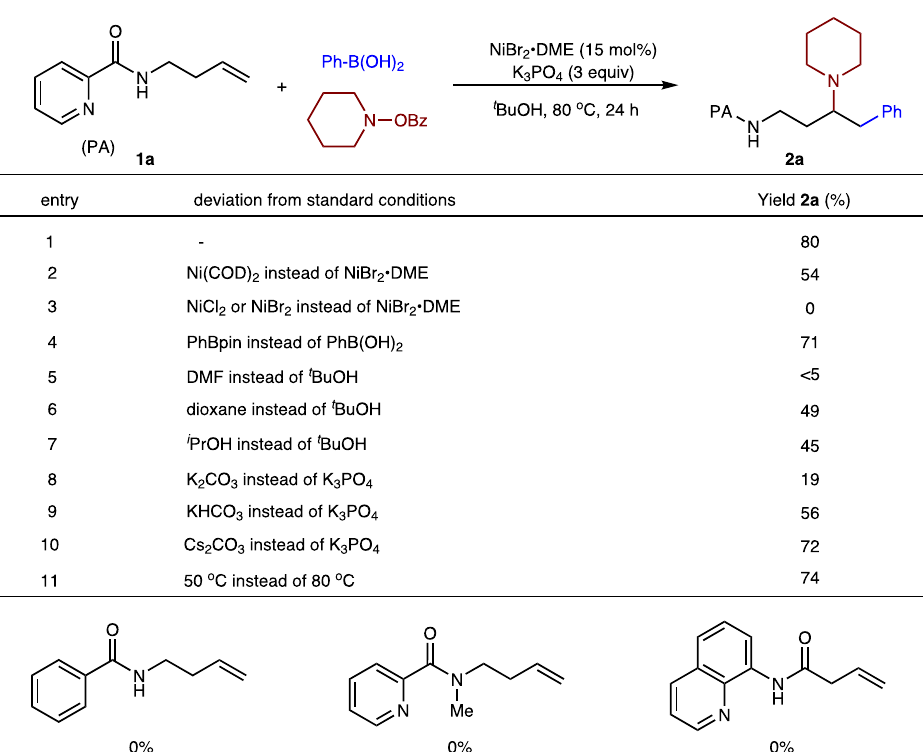
Fig. 2 Variation of reaction parameters. Reactions conditions: 1a (0.2 mmol), PhB(OH) 2 (3 eq), piperidino benzoate (2 eq), t BuOH (2 mL). Yields were for isolated and puri fi ed